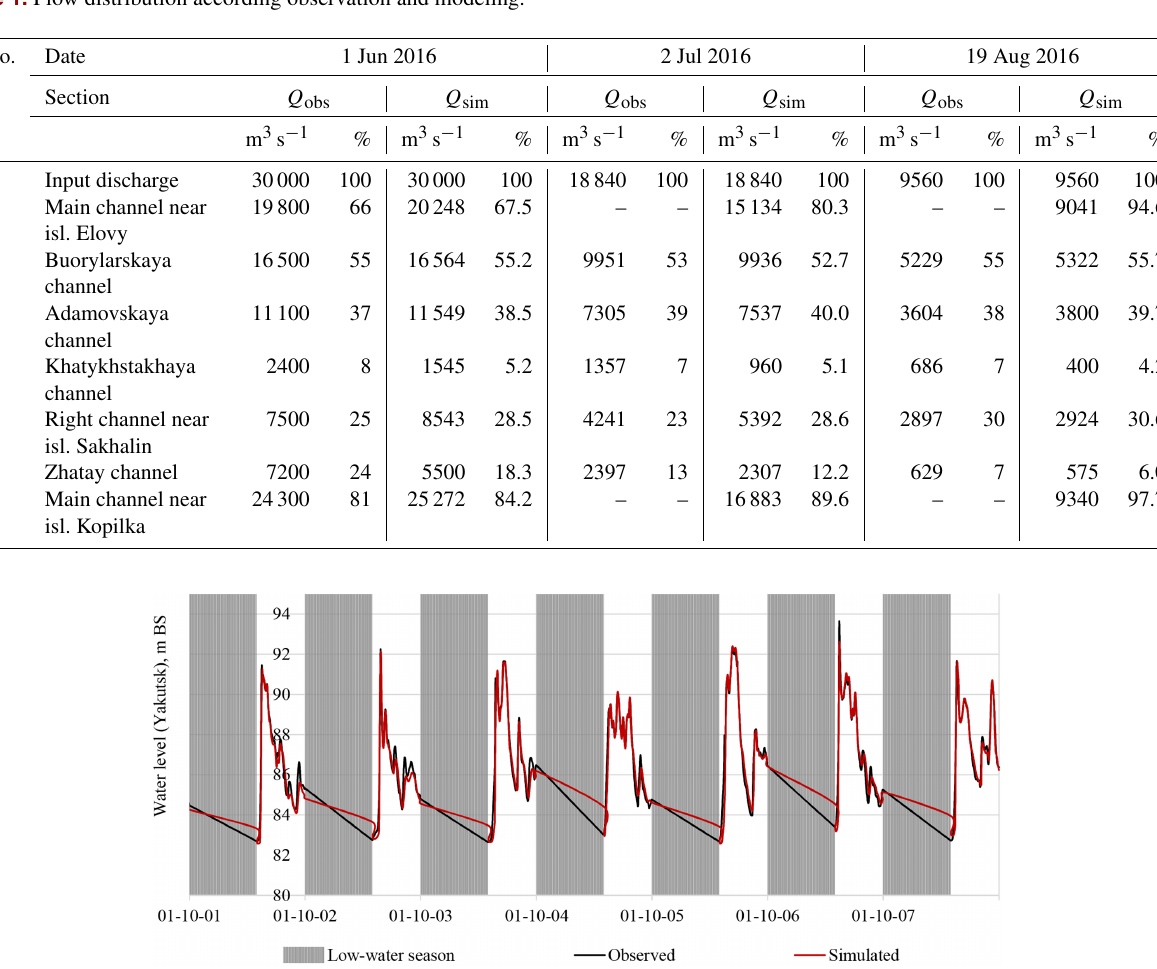
Figure 2. Observed and modelled water levels at the Yakutsk gauge at 2001–2008 (ice-free